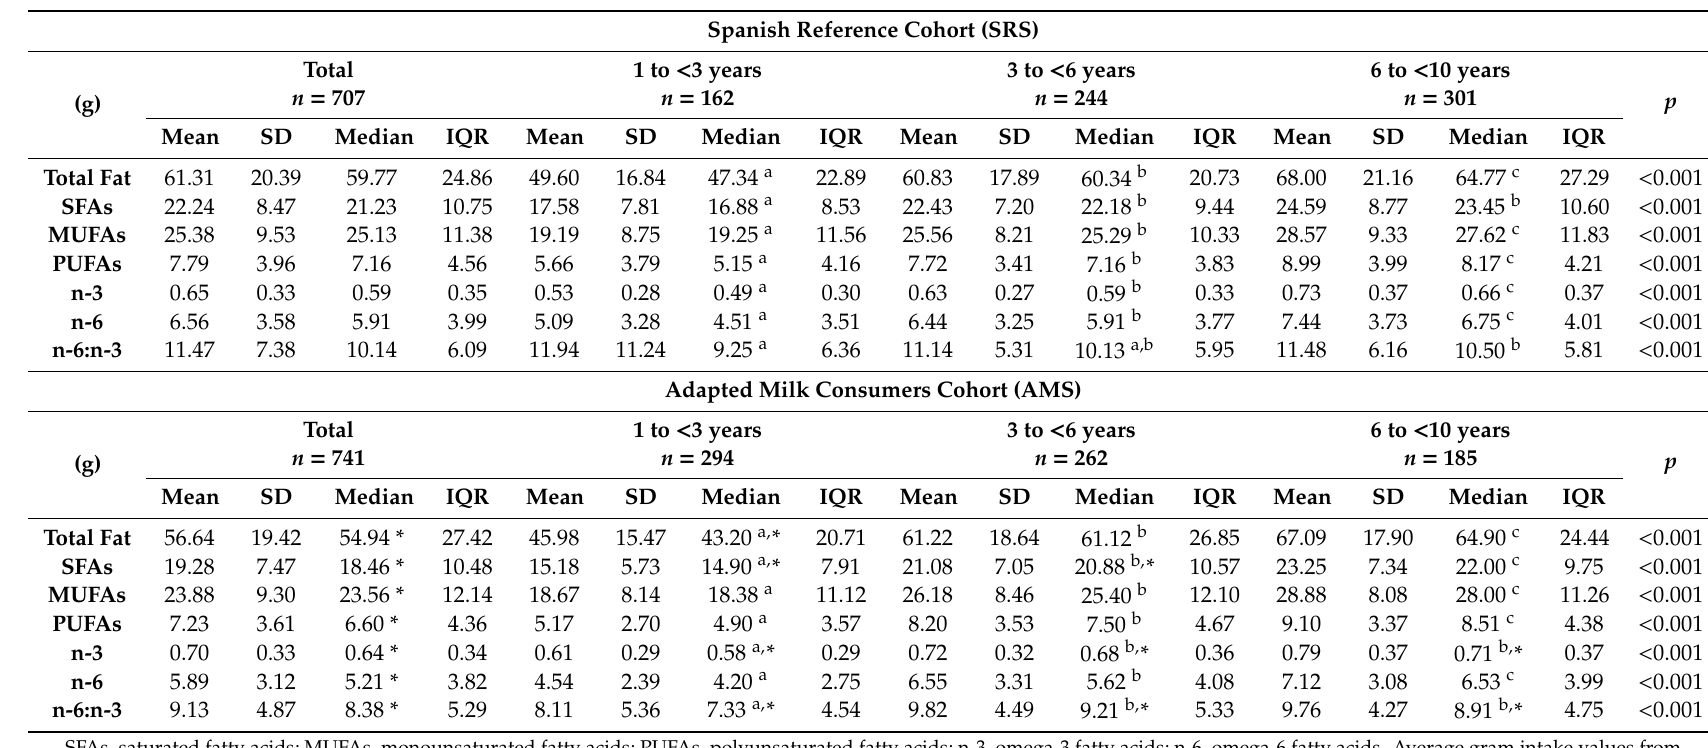
Table 2. Total lipid and main fatty acids intake from two 24 h dietary recall for two cohorts of the Nutritional Study in the Spanish Pediatric Population (EsNuPI) according to age group ( n =